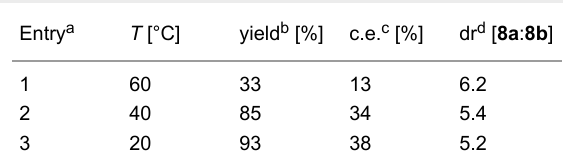
Table 1: Effect of temperature onto yield and stereoselectivity of the electrochemical reduction of 7a on a lead